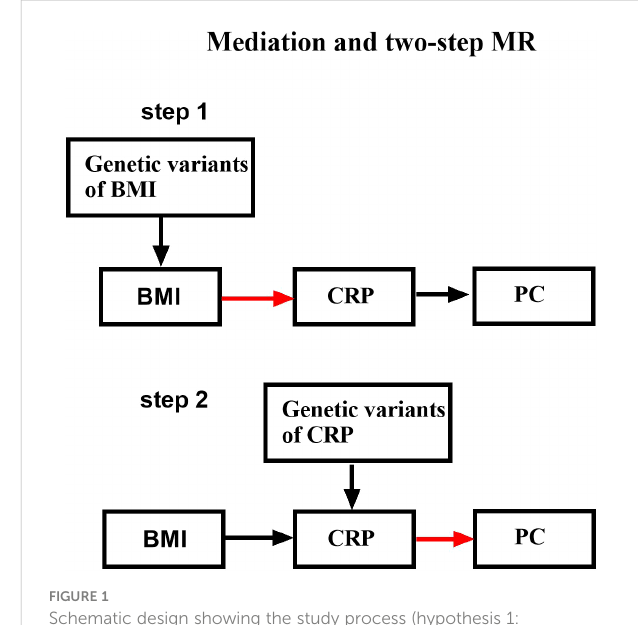
FIGURE 1 Schematic design showing the study process (hypothesis 1: signi fi cantly correlated with exposure; hypothesis 2: not correlated with outcome; hypothesis 3: not correlated with